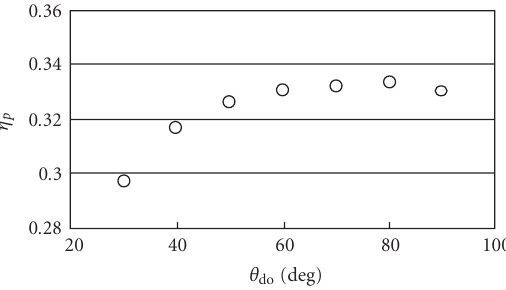
Figure 9: E ff ect of di ff user setting angle of outer guide vane on peak e ffi ciency (exhalation, θ ni = 15 ◦ ).